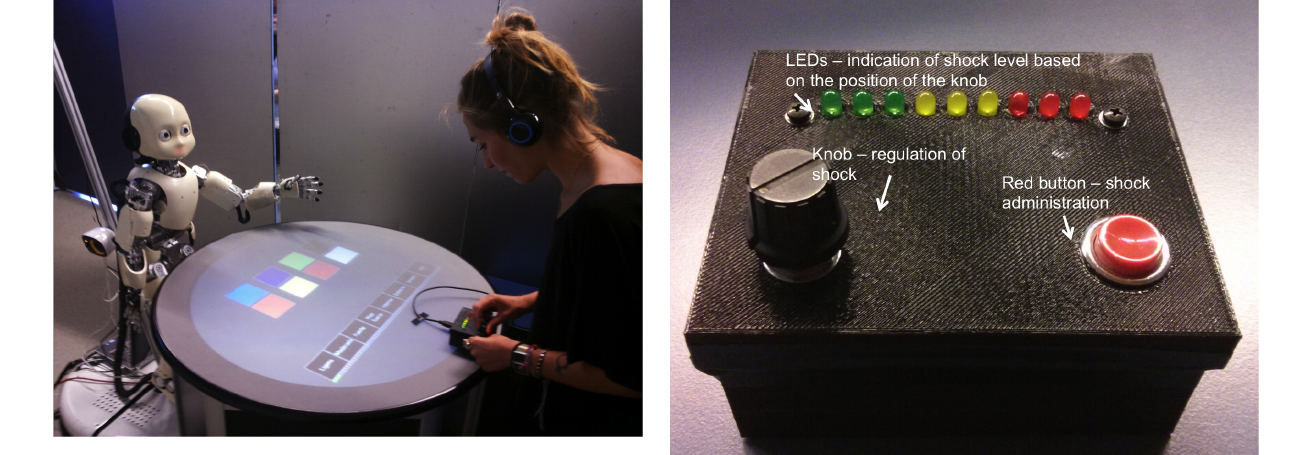
Figure 9: Experimental setup: the robot and the participant are facing each other while playing the color matching game on the Reactable. The participant listens the pre-recorded voice messages via wireless headphones. In front of the participant is the device to administer the simulated electrical shocks.